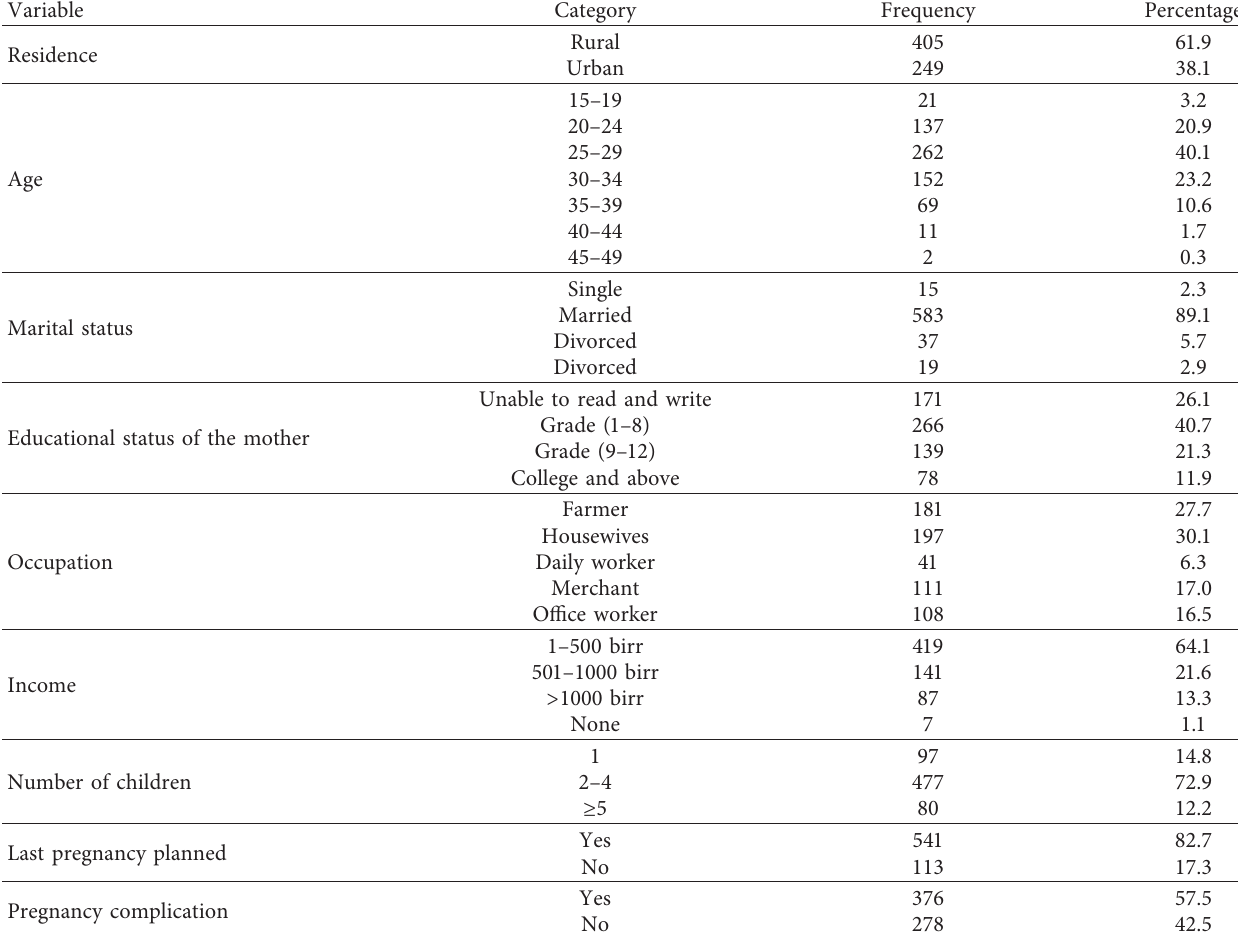
Table 1: Sociodemographic characteristics of study participants.